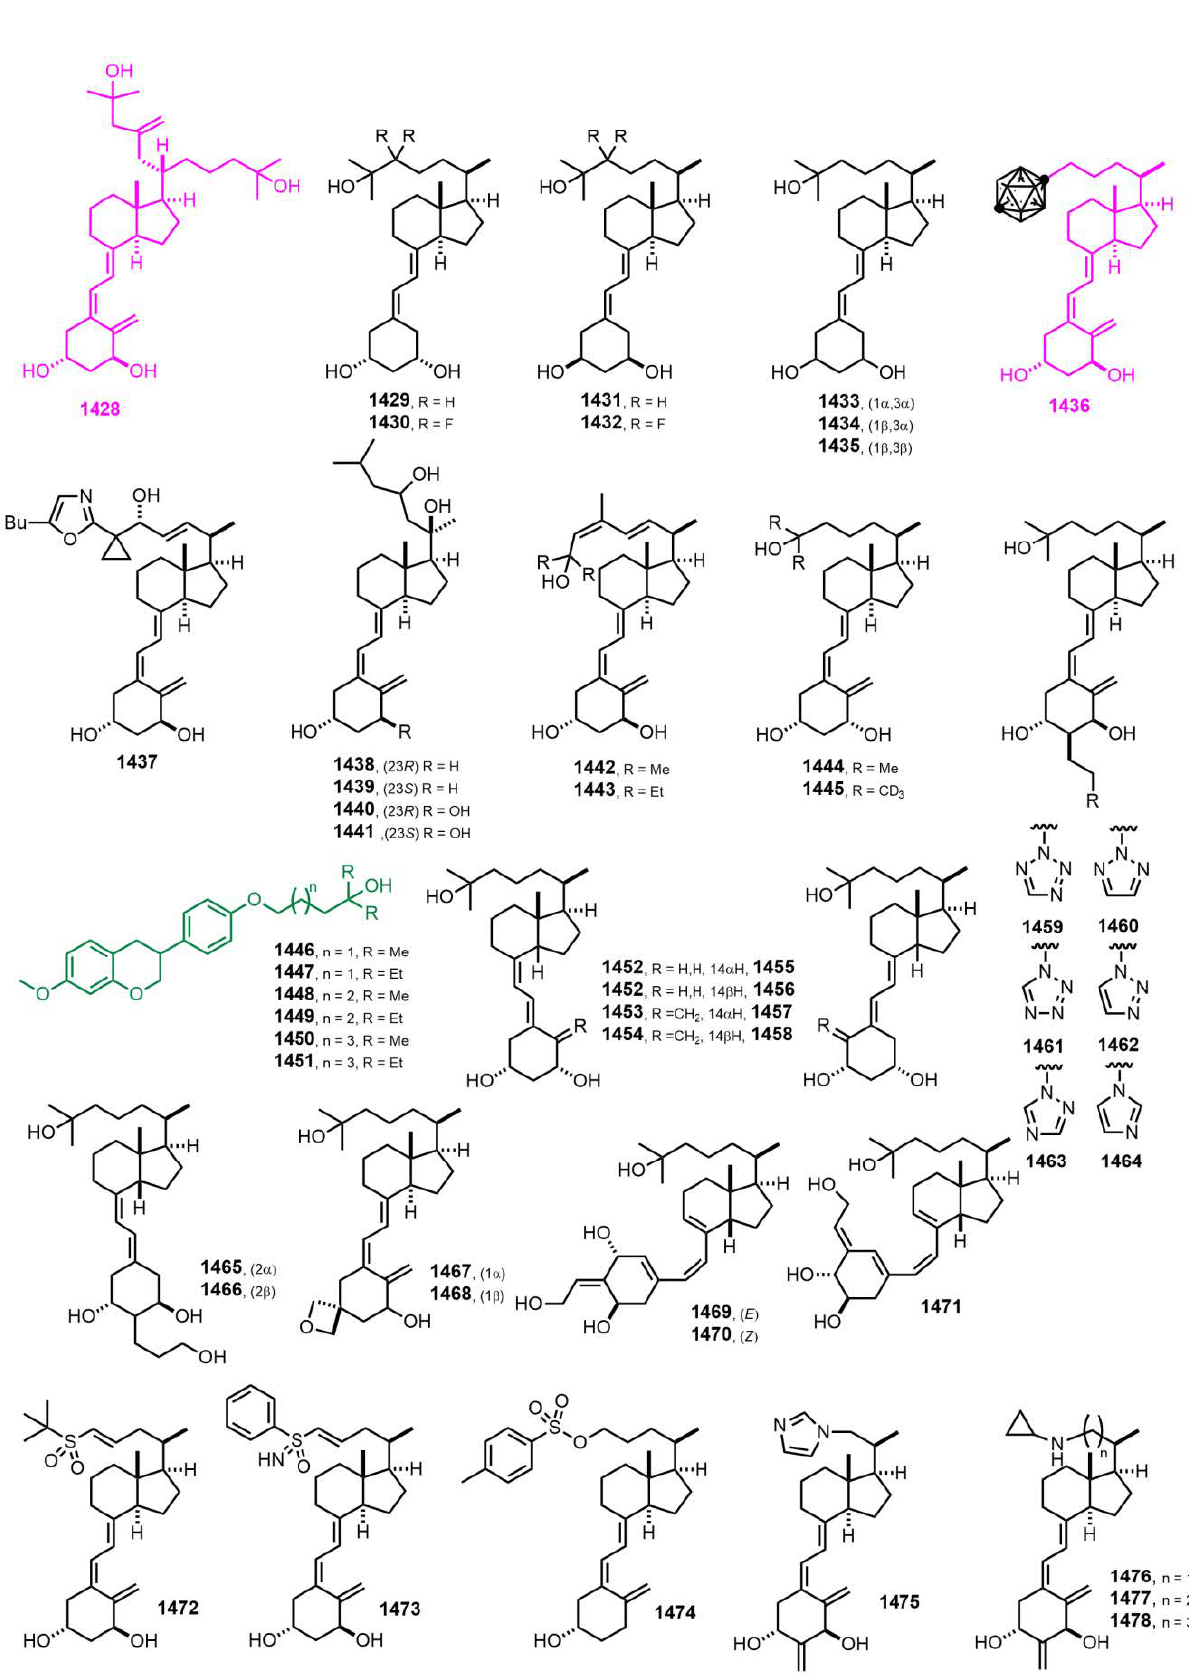
Figure 25. (2015-2017) [337 – 351].